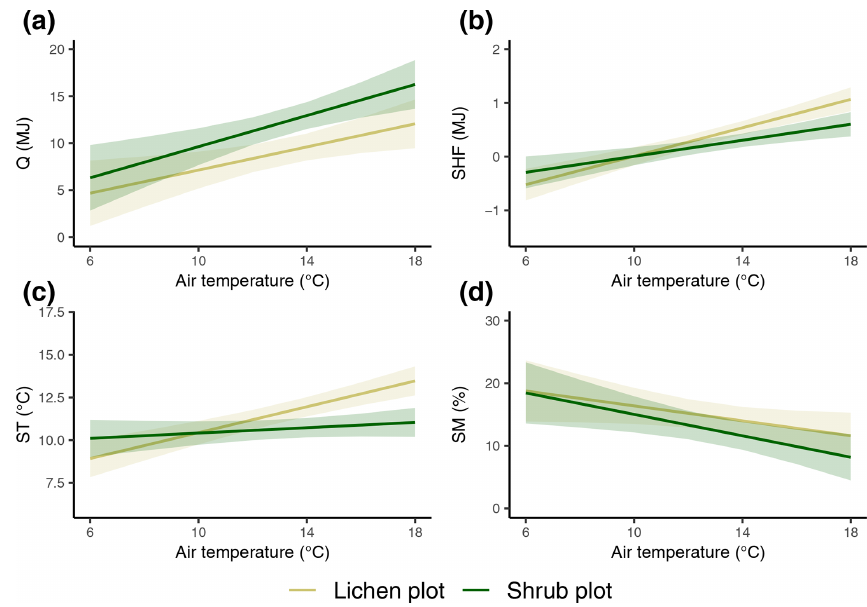
Figure 5. The modeled relationships with 95% confidence intervals between vegetation type, daily average reference air temperature and daily total net radiation (a) , daily total soil heat flux (b) , daily average soil temperature (c) , and daily average soil moisture (d) . See Table 2 for details on the mixed models.